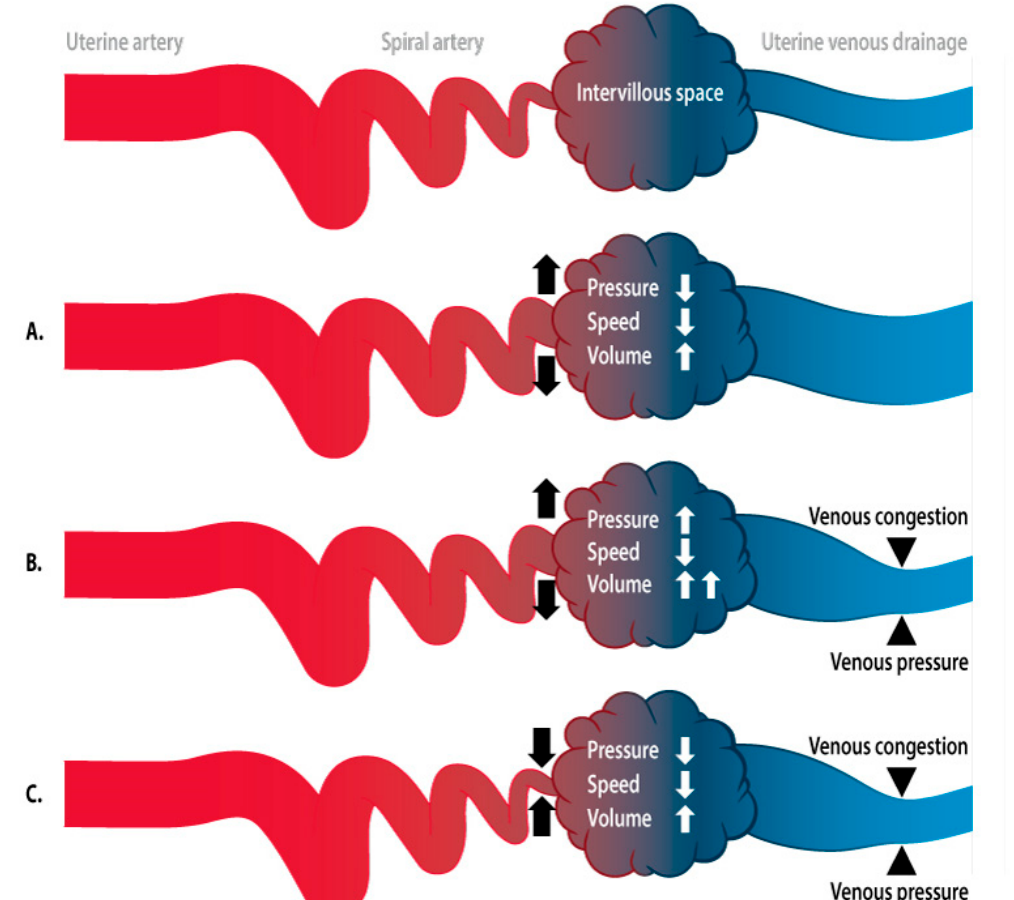
Figure 1. Schematic presentation of the hemodynamics of the intervillous space. As in any capillary network, the functioning of the intervillous space is determined by a balanced intra- and extravascular exchange under flow conditions that are tightly regulated by arteriolar and venular activity in accordance with osmotic forces of the perivascular tissue. ( A ): Hemodynamic effects in the intervillous space caused by spiral artery dilatation. In this condition, the flow volume increases, but flow velocity and pressure decrease. This condition allows optimal maternal–fetal exchange. ( B ): Hemodynamic effects in the intervillous space when spiral artery dilatation occurs after inadequate adaptation of the venous outflow. There is stasis of blood that cannot be drained efficiently and causes congestion, responsible for increased pressure and reduced flow velocity in the intervillous space. ( C ): Impact of the incomplete dilatation of the spiral arteries on the conditions presented in Figure 1B. The reduced spiral artery blood supply reduces the degree of congestion and pressure in the intervillous space, at the cost of a reduced flow volume. This mechanism might improve the maternal–fetal exchange when there are unbalanced pressure/flow conditions in the intervillous space as in Figure 1B.